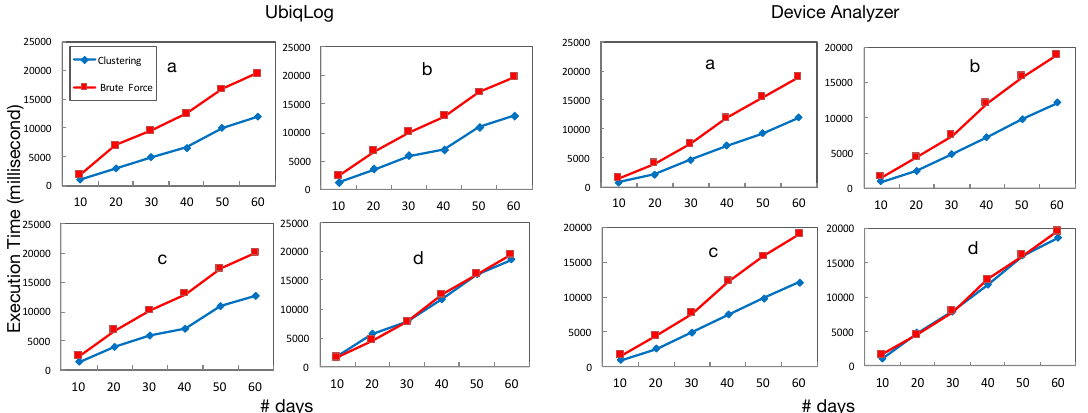
Figure 7. Four different search execution time samples for UbiqLog and Device Analyzer. The y -axis shows execution time in milliseconds and the x -axis shows the number of days that will be searched.